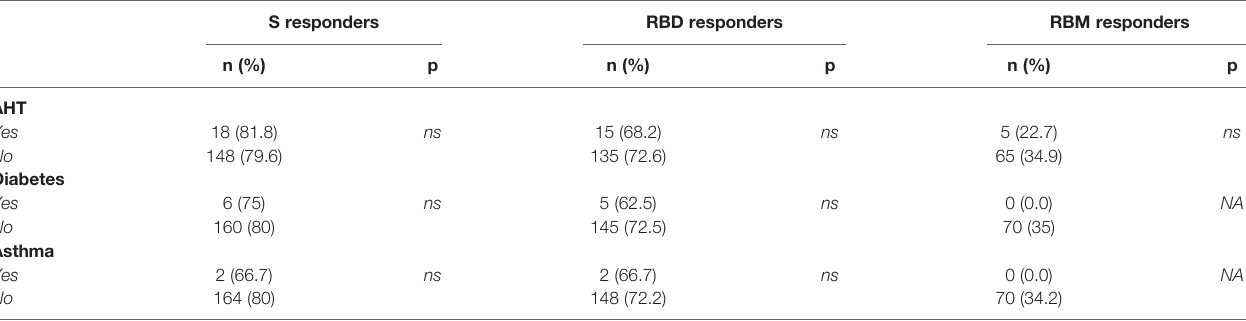
TABLE 4 | Proportion of antibody responders for S, RBD, and RBM in conjunction with the presence or absence of comorbid conditions among COVID-19 patients. S responders RBD